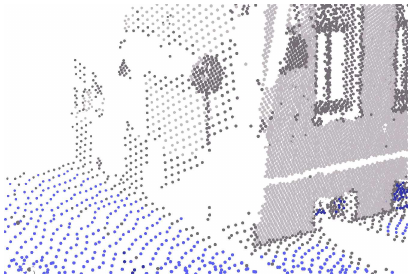
Figure 9. Example of an undetected pole of a traffic sign, near to a building wall (falsely classified as wall inventory).